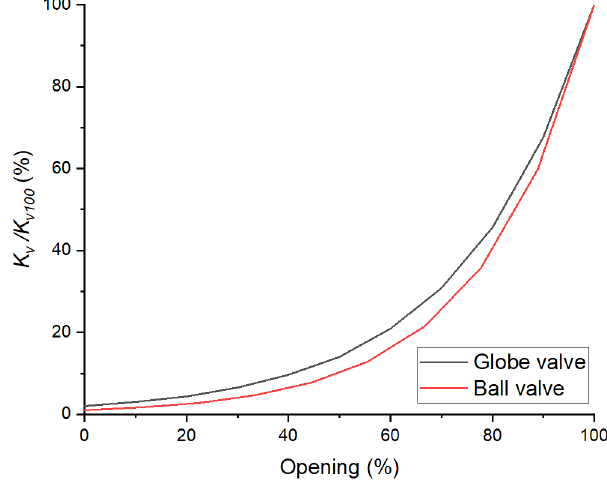
Figure 3. The control valve characteristic curve. Table 3. Detailed information for the control valve. Table 3. Detailed information for the control